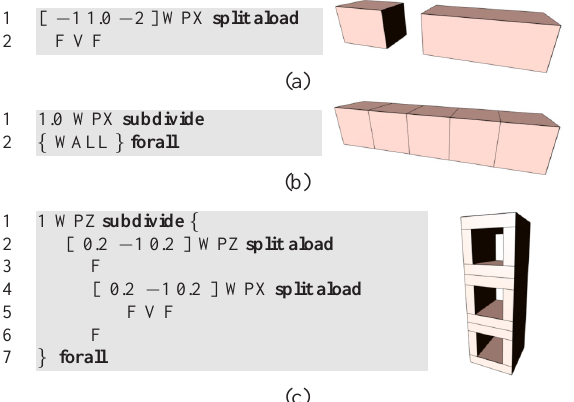
Figure 6: The split rule in (a) splits a volume into three symbols, F (“fill”), V (“void”), and F, along the horizontal axis, where the empty box should be one unit wide and the filled nonterminals should share the remaining space according to a proportion of 1 : 2 . The subdivide rule (b) splits the box into equal parts with a minimum size of one unit. Both kinds of rules can be combined in interesting ways (c).